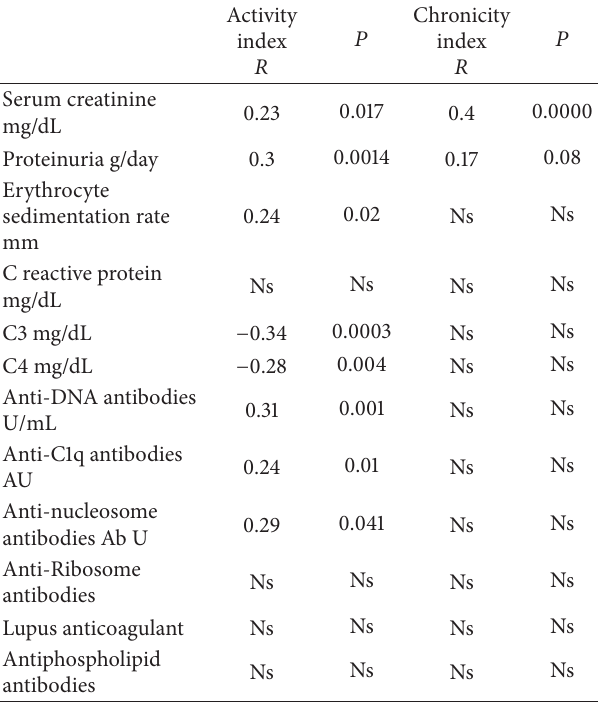
Table 3: Correlations of activity and chronicity index with clinical and immunological